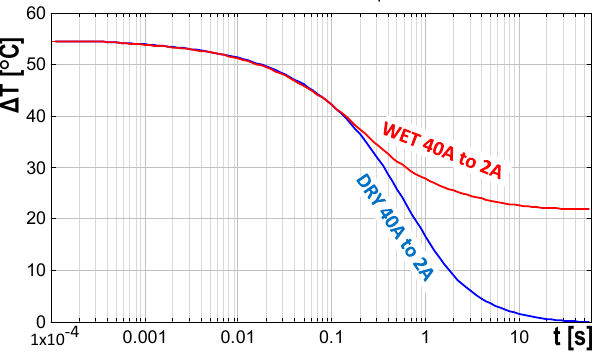
Figure 6. Component on high and low conductance boards, cooling curves fit at hot point (from [11]). Normalizing the cooling curves with the applied power we obtain the Z th curves . (They